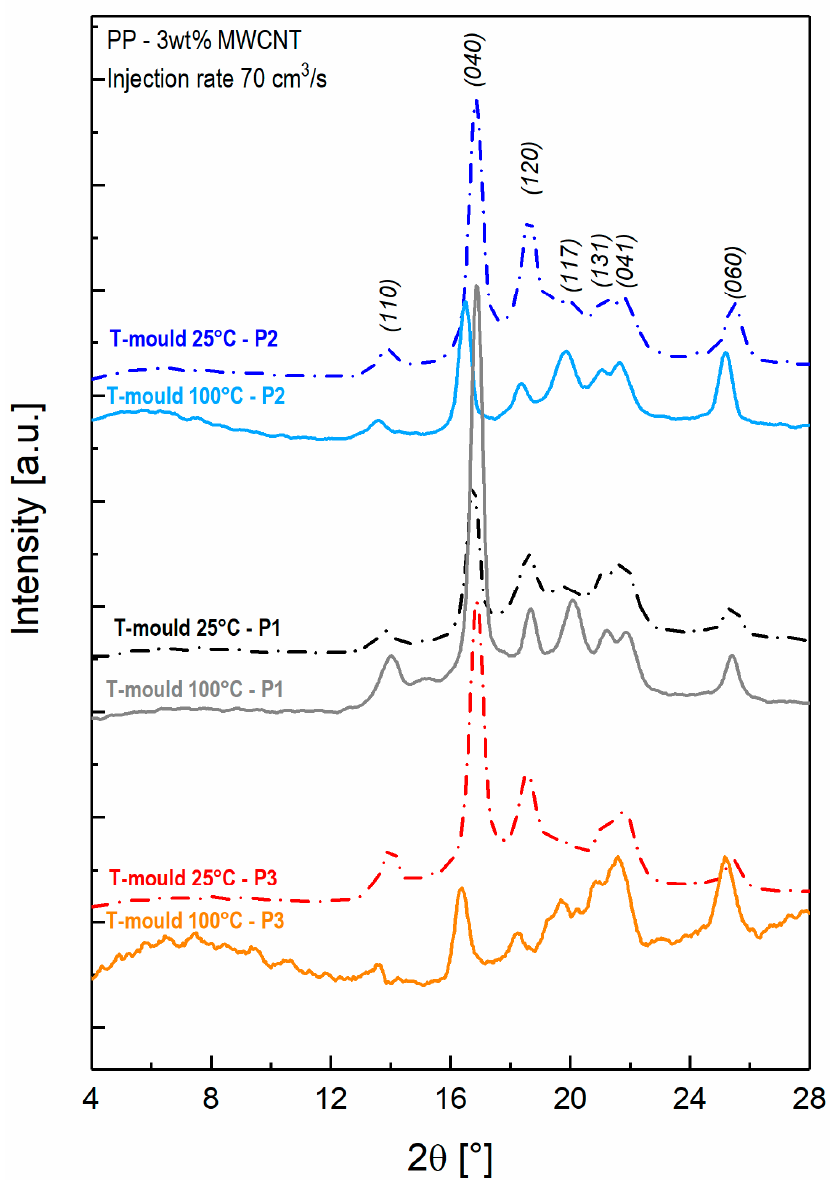
Figure 5. X-ray diffraction patterns of 3 wt% MWCNT nanocomposites, manufactured at mold temperatures 25 °C and 100 °C in the three positions over the samples.